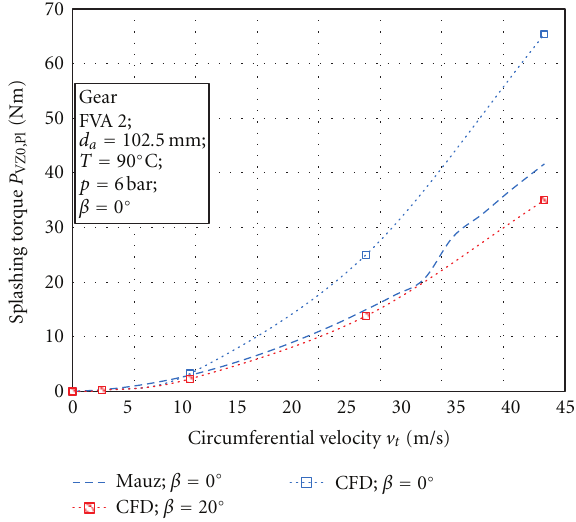
Figure 13: Results in terms of resistant torque versus circumferen- tial velocity—Influence of the helix angle.